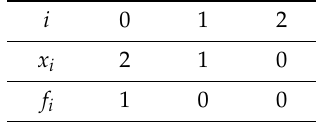
Table 3. Interpolation data.